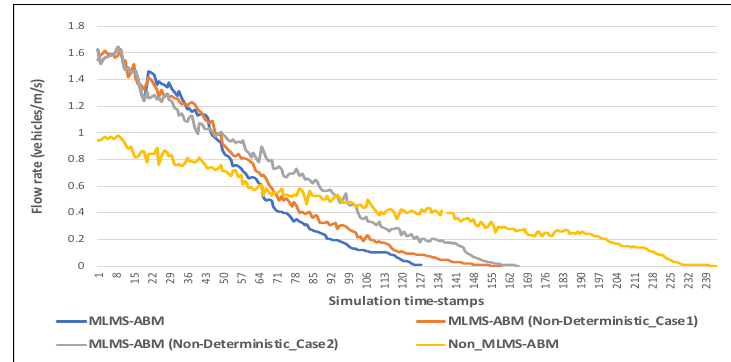
Figure 8. Tra ffi c flow during simulation time (hypothetical road network). Figure 8. Traffic flow during simulation time (hypothetical road network). Figure 8. Traffic flow during simulation time (hypothetical road network).